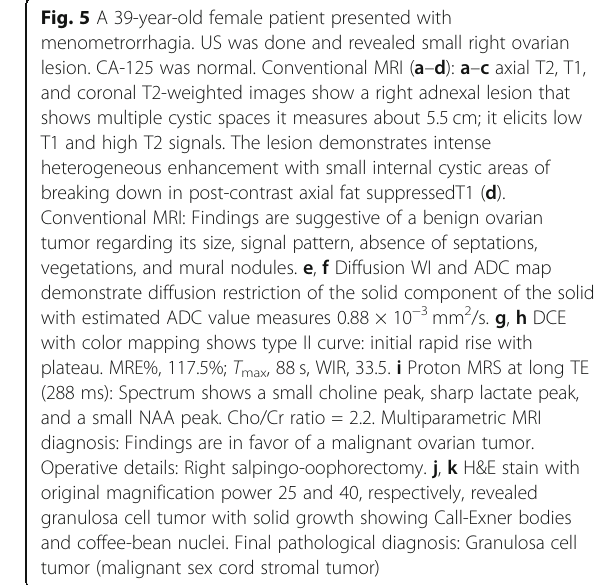
Fig. 5 A 39-year-old female patient presented with menometrorrhagia. US was done and revealed small right ovarian lesion. CA-125 was normal. Conventional MRI ( a – d ): a – c axial T2, T1, and coronal T2-weighted images show a right adnexal lesion that shows multiple cystic spaces it measures about 5.5 cm; it elicits low T1 and high T2 signals. The lesion demonstrates intense heterogeneous enhancement with small internal cystic areas of breaking down in post-contrast axial fat suppressedT1 ( d ). Conventional MRI: Findings are suggestive of a benign ovarian tumor regarding its size, signal pattern, absence of septations, vegetations, and mural nodules. e , f Diffusion WI and ADC map demonstrate diffusion restriction of the solid component of the solid with estimated ADC value measures 0.88 × 10 − 3 mm 2 /s. g , h DCE with color mapping shows type II curve: initial rapid rise with plateau. MRE%, 117.5%; T max , 88 s, WIR, 33.5. i Proton MRS at long TE (288 ms): Spectrum shows a small choline peak, sharp lactate peak, and a small NAA peak. Cho/Cr ratio = 2.2. Multiparametric MRI diagnosis: Findings are in favor of a malignant ovarian tumor. Operative details: Right salpingo-oophorectomy. j , k H&E stain with original magnification power 25 and 40, respectively, revealed